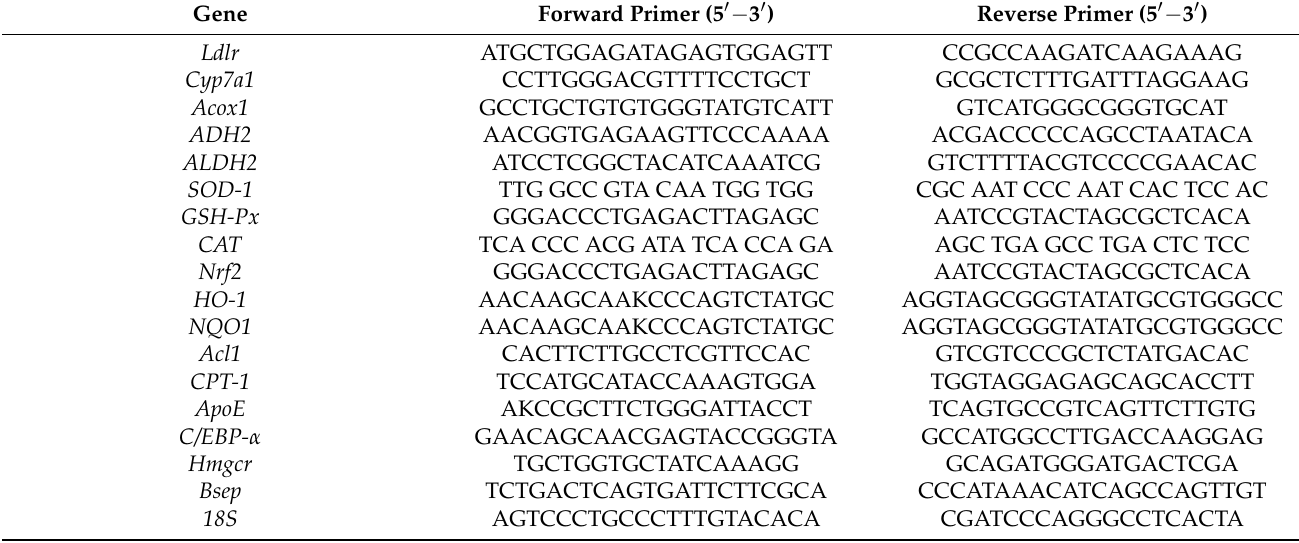
Table 1. Primer sequences for quantitative real-time PCR